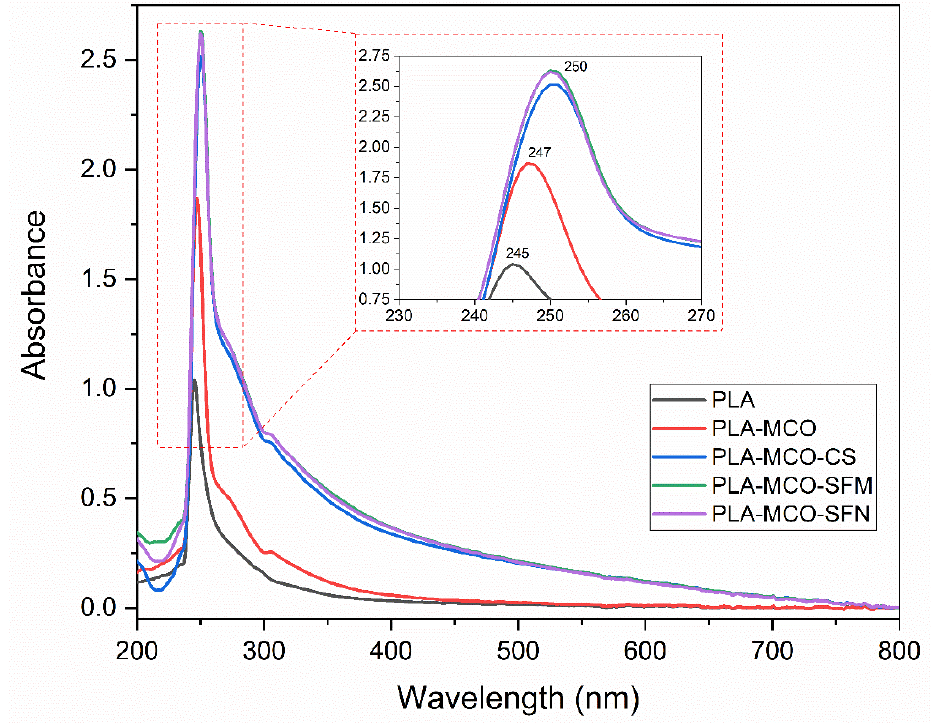
Figure 7. UV-vis absorbance spectra of PLA and PLA blended with MCO and silk, and the expanded area between 230 and 270 nm.